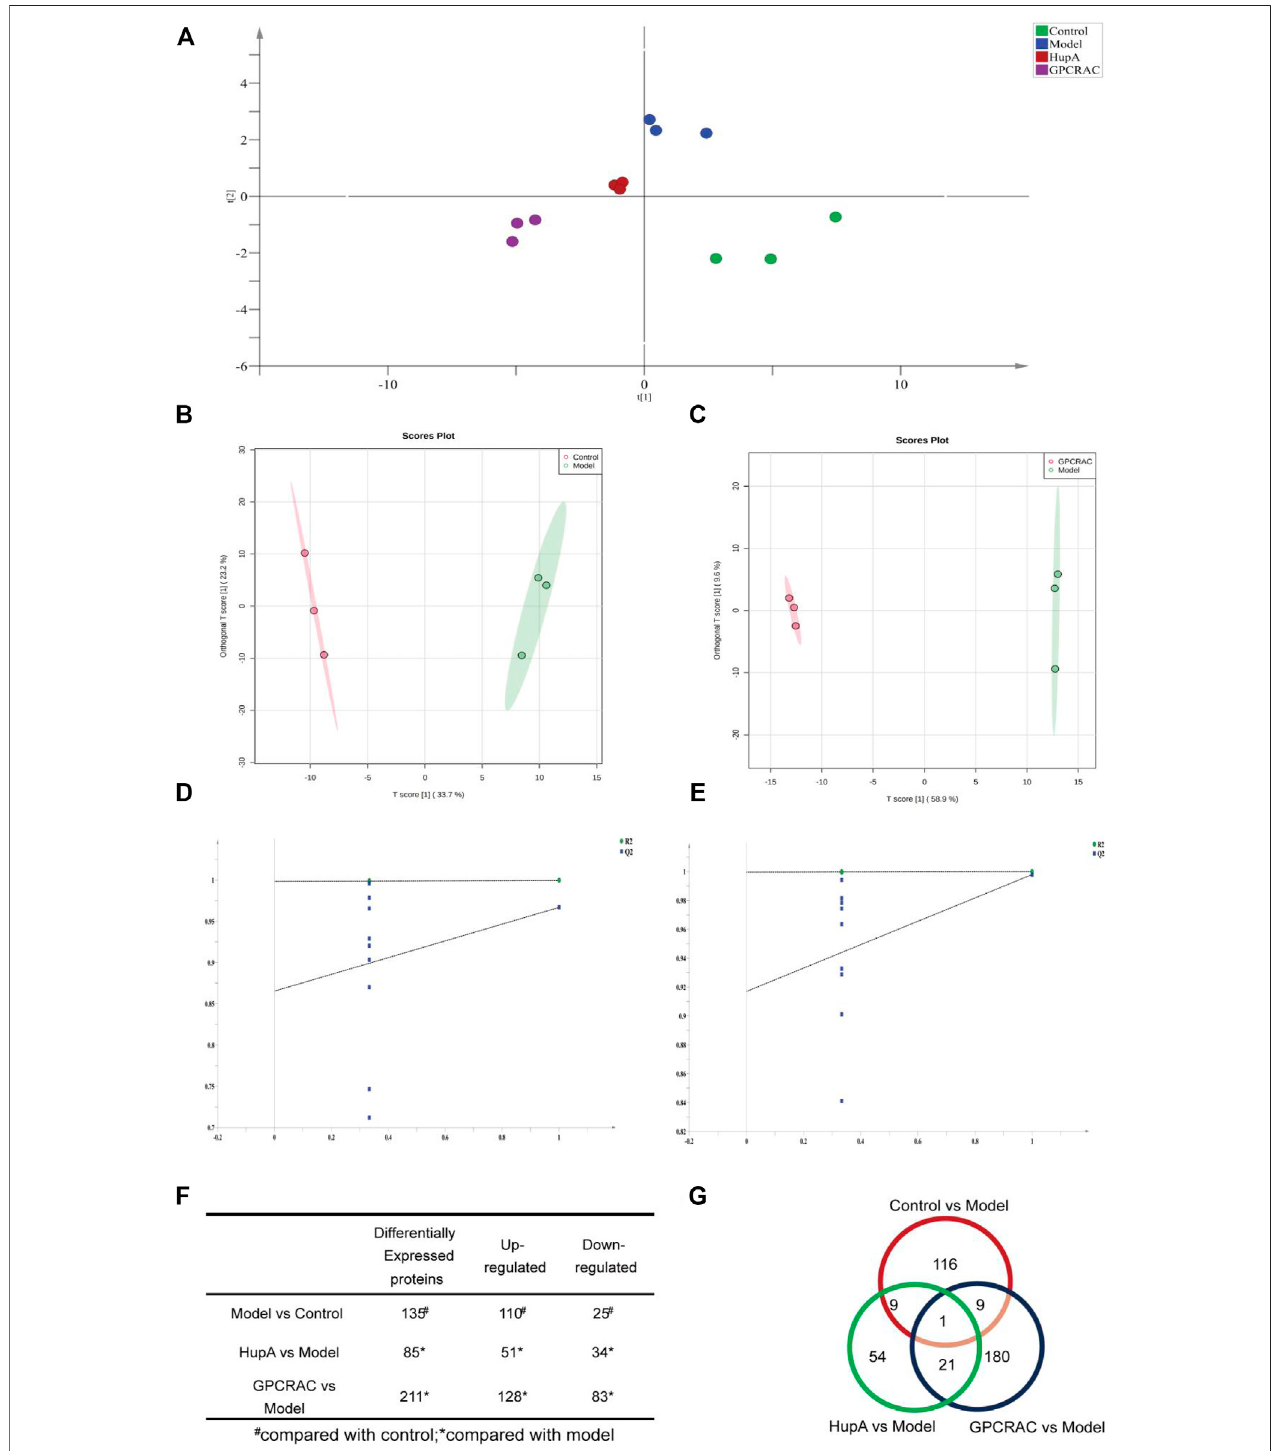
FIGURE 5 | Evaluation of differentially expressed proteins; PLS-DA scores plot of different group samples (A) ; OPLS-DA scores plot model revealed a clear separation between control vs. model (B) and model vs. GPCRAC extracts (C) groups; The corresponding permutation test (D,E) ; The fold-change cutoff was set at ≥ 1.2or ≤ 0.883with p < 0.05.Identi fi edup-ordown-regulatedproteinsinhippocampusproteomicsfromeachgroup (F) ;Venndiagramanalysisofdifferentiallyexpressed proteins (G) .